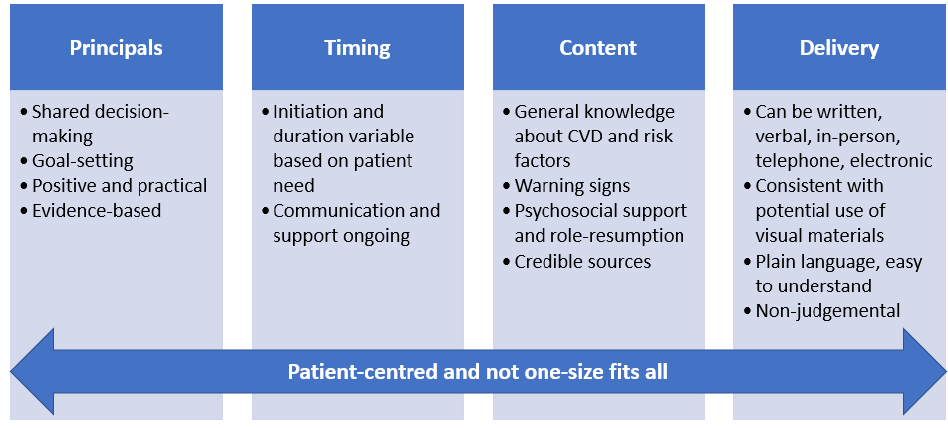
Figure 1. Schematic overview and education and information needs for patients.